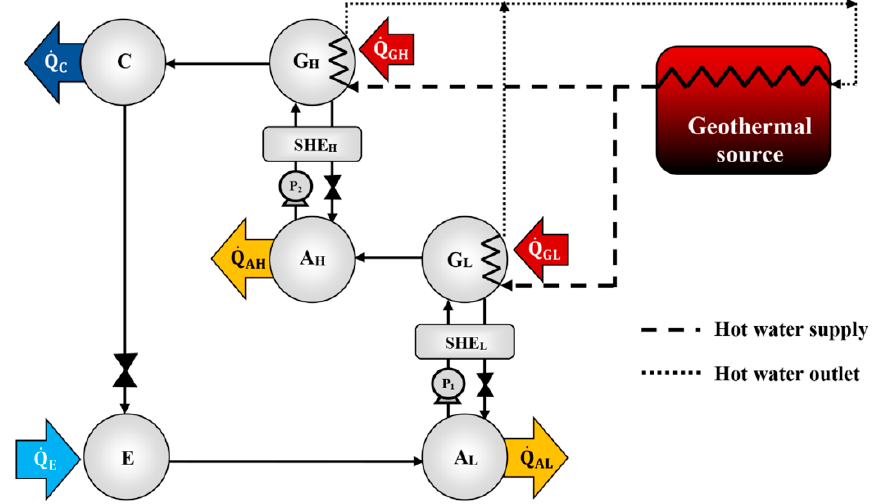
Figure 3. Schematic diagram of the interconnection between the geothermal resource and the half-effect cycle.